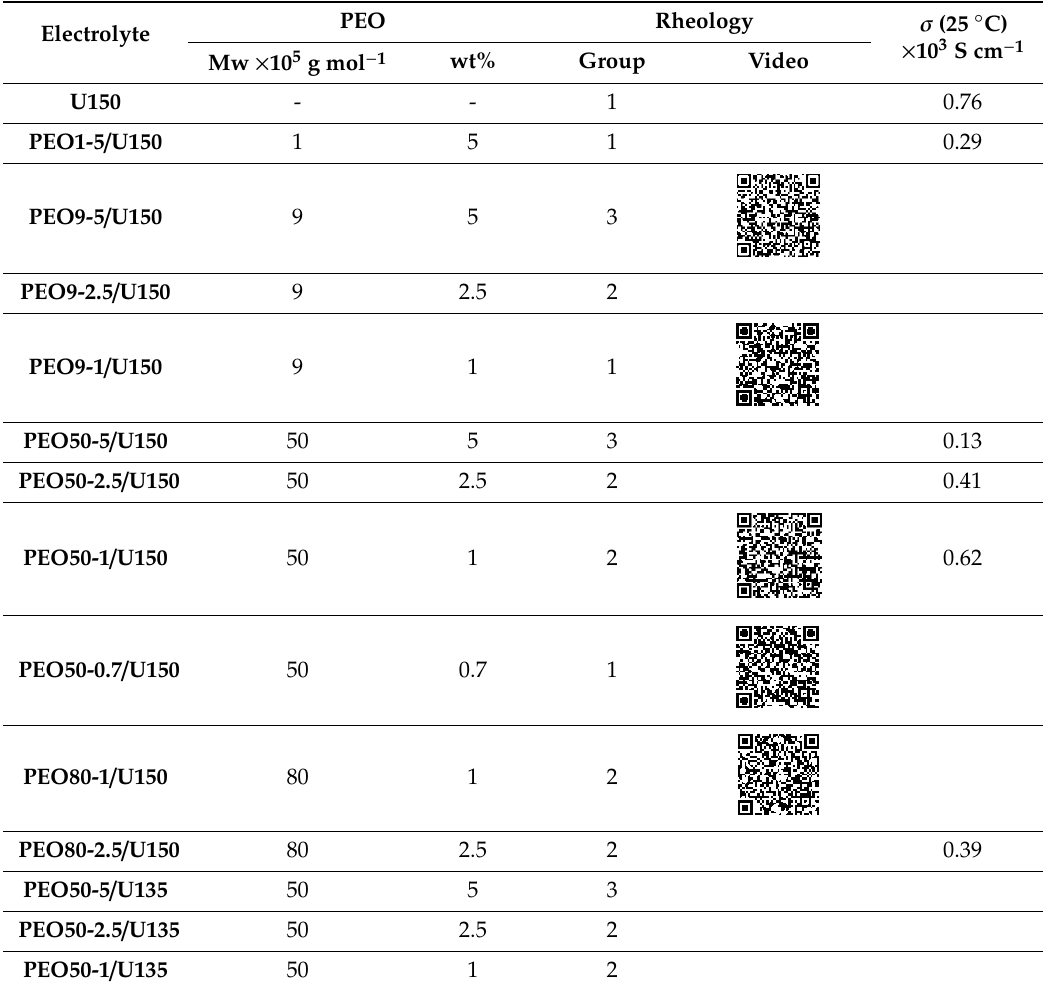
Table 1. Nomenclature and composition of the electrolytes prepared, their classification into the three rheology groups described in the text, videos illustrating their rheology, elastomeric and sticky character, and ionic conductivity at 25 °C.